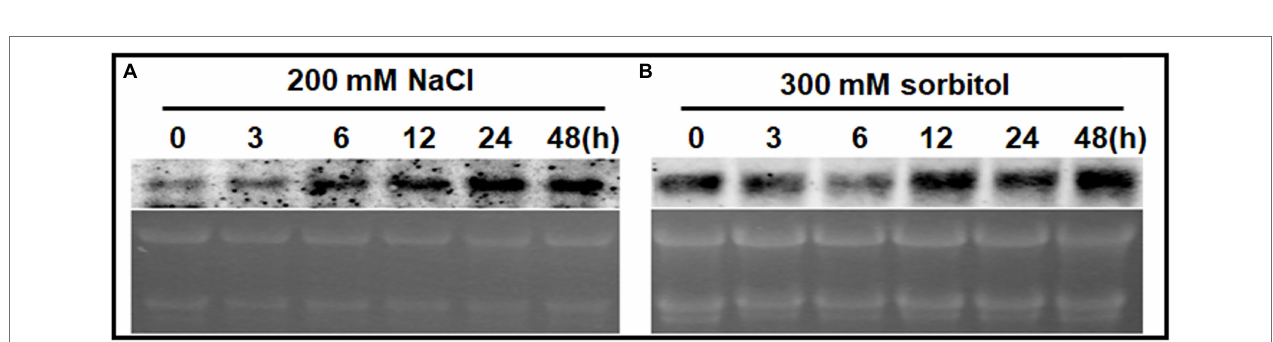
FIGURE 4 | The mRNA expression levels of ChPAP2 at various time points after exposure to NaCl- and sorbitol-stress treatments. Northern blot analyses of the ChPAP2 gene’s expression levels in TSA Chlorella cells using a digoxigenin-labeled ChPAP2 cDNA probe. The total RNA (5 μ g) was extracted from Chlorella cells treated independently with 200-mm NaCl (A) and 300-mm sorbitol (B)